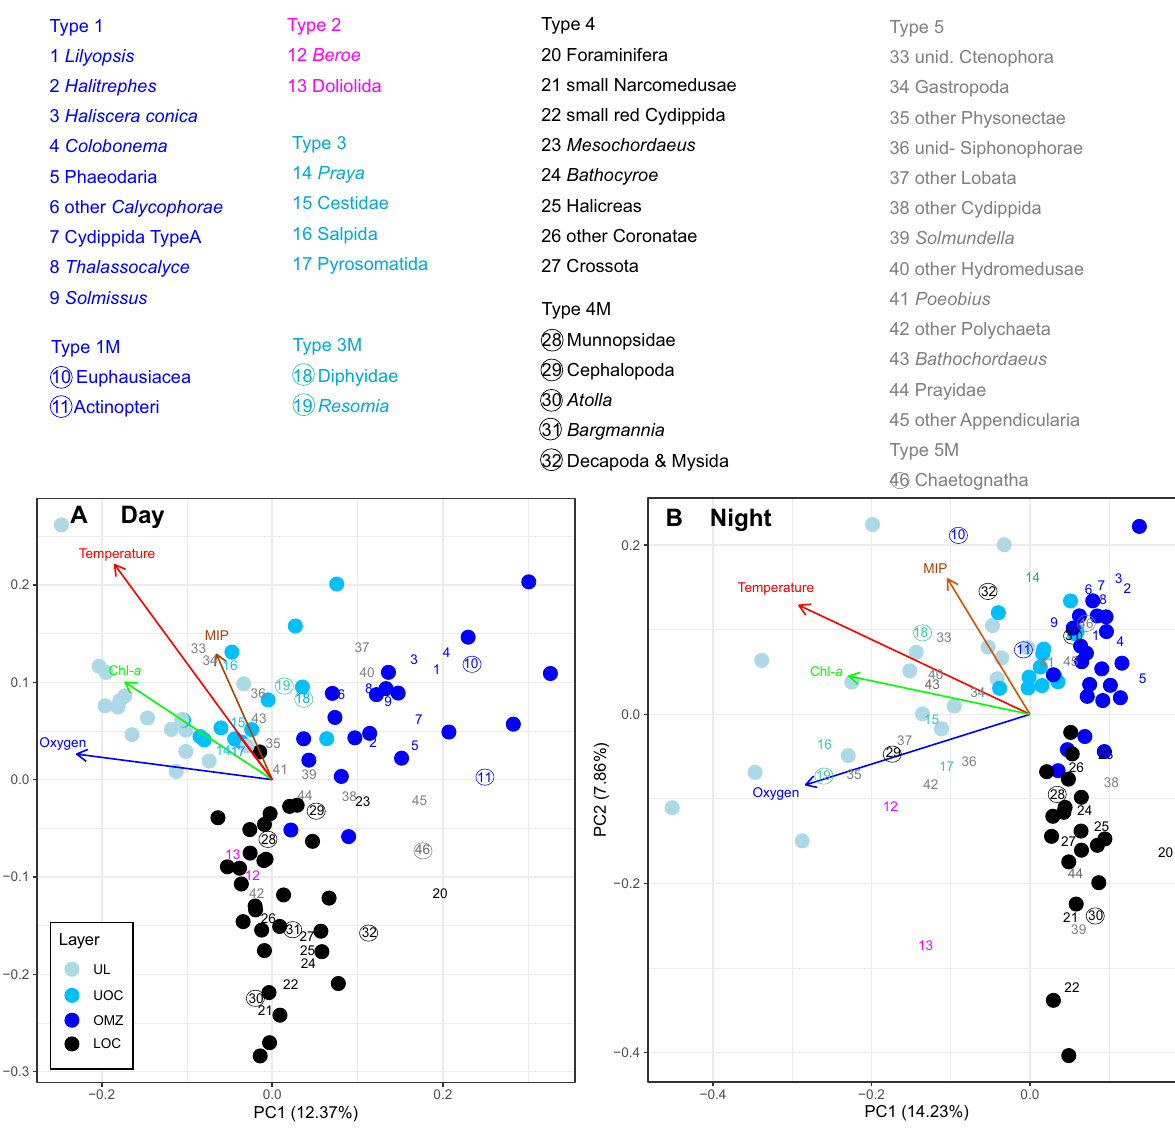
Figure 5. Principal component analysis of the daytime ( A ) and nighttime ( B ) community composition (46 taxa, see Table S2). Circles are samples, with the color indicating the four nominal depth layers. One sample is a discrete observation (one transect at a given station). Taxa are represented by numbers, color coded by the identified distribution type 1 (in OMZ, blue), 2 (bimodal, magenta), 3 (above OMZ, cyan), 4 (below OMZ, black) and 5 (no clear pattern, grey). Numbers in circles identify taxa with diel vertical migration (M). The mid- point of the taxon numbers is the PC1/PC2 score location. Vectors are only drawn for environmental variables (oxygen, temperature, chlorophyll-a, and particles). The layer abbreviations refer to: upper layer (UL), upper oxycline (UOC), oxygen minimum zone (OMZ), and lower oxycline